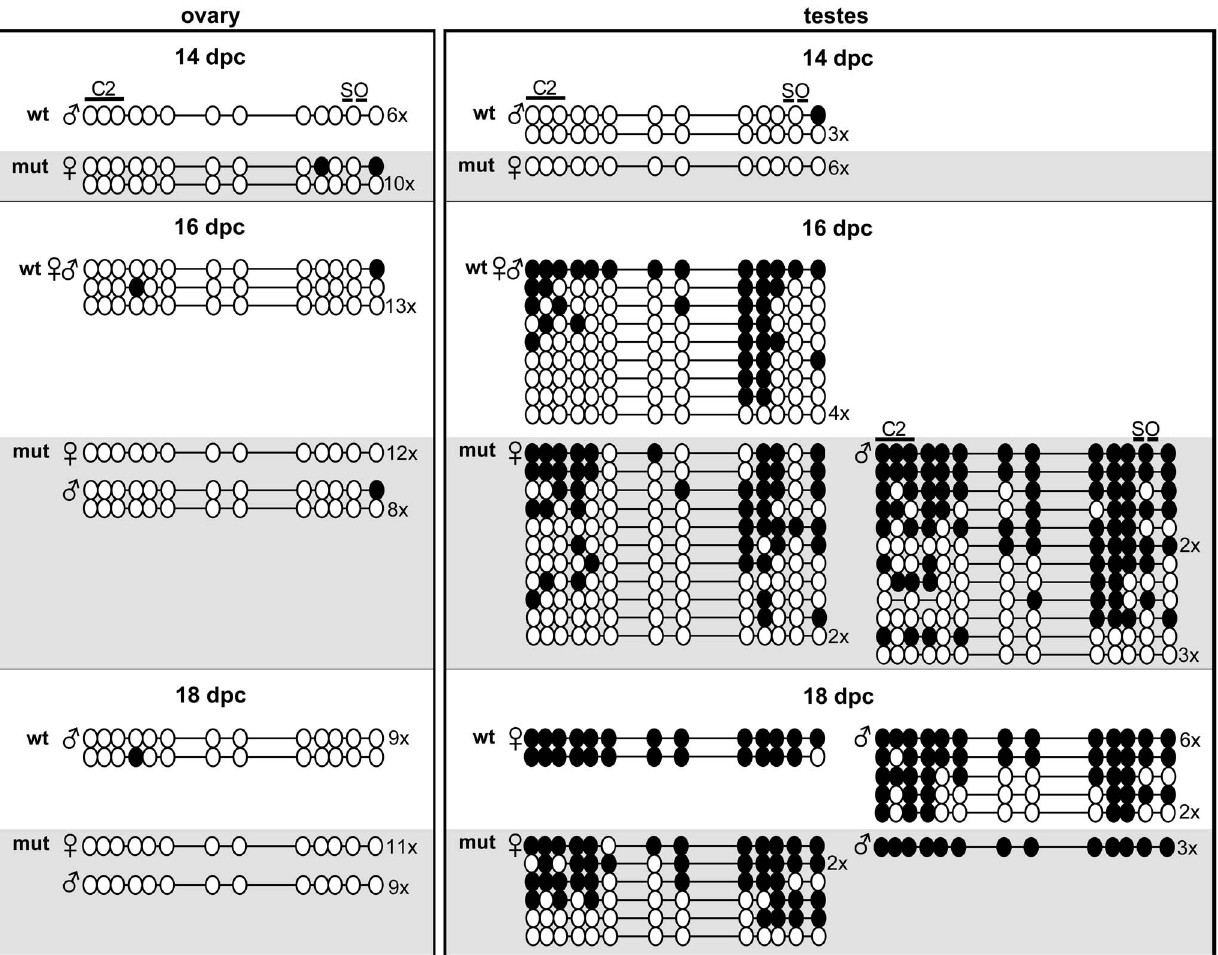
Figure 6. Methylation profiles of WT and mutant ICRs from female and male embryonic germ cells. Bisulfite sequencing of the CTCF site 2 and Sox-OctA and B region are shown for germ cells isolated from 14, 16, and 18 dpc ovaries and testes from heterozygous mutant embryos. WT and mutant alleles are denoted by white and grey backgrounds respectively. The parental origin of alleles is indicated by the symbol to the left of sequence graphical representations. Each block of bisulfite sequences was the result of 1–2 separate PCR reactions performed with DNA from 1 6 10 3 – 1 6 10 4 GFP-sorted germ cells obtained from 4–16 pooled gonads. DNAs from separate PCR reactions were cloned separately.